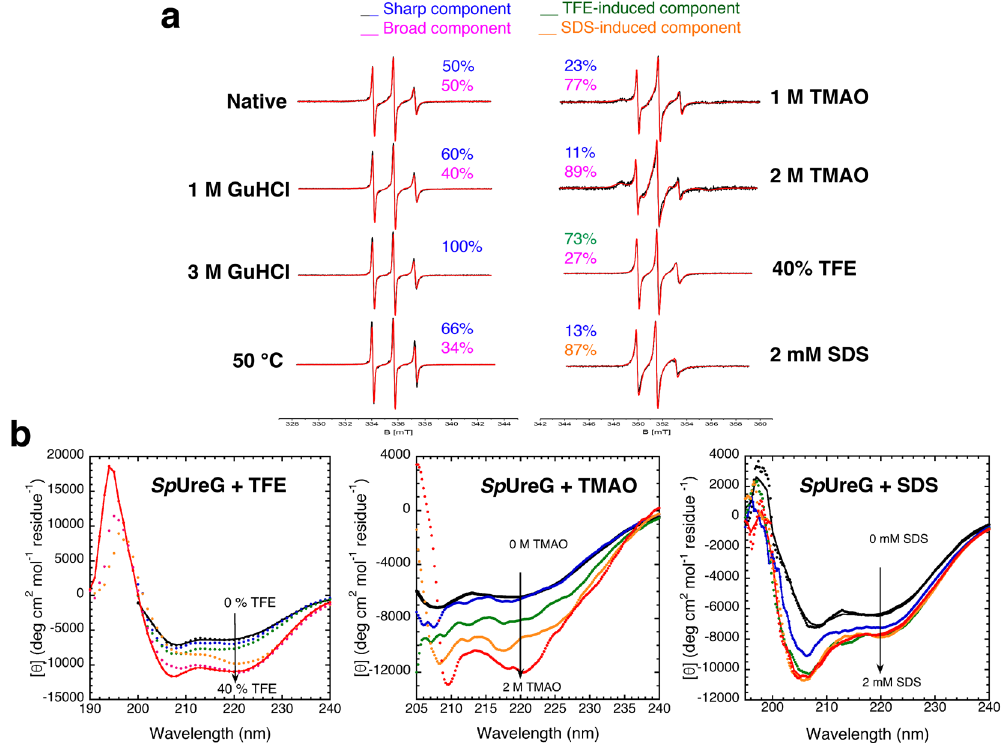
Figure 3. Effects of different additives and temperature on Sp UreG structural flexibility. ( a ) SDSL-EPR spectra of Sp UreG-MTSL (62 µ M in 20 mM TrisHCl pH 8, 150 mM NaCl) at different temperatures and with various additives, as indicated. The spectra simulations (red) are superimposed to the EPR spectra (black). ( b ) Titration of Sp UreG (20 µ M, in 20 mM TrisHCl pH 8, 150 mM NaCl, 1 mM TCEP) with different additives (TFE, TMAO, SDS), followed by CD. TFE concentrations: 0%, black; 5%, blue; 10%, green; 20%, orange; 30%, magenta; 40%, red. TMAO concentrations: 0 M, black; 0.4 M, blue; 1 M, green; 1.5 M, orange; 2 M, red. SDS concentrations: 0 mM, black; 0.5 mM, blue; 1 mM, green; 1.5 mM, orange; 2 mM,